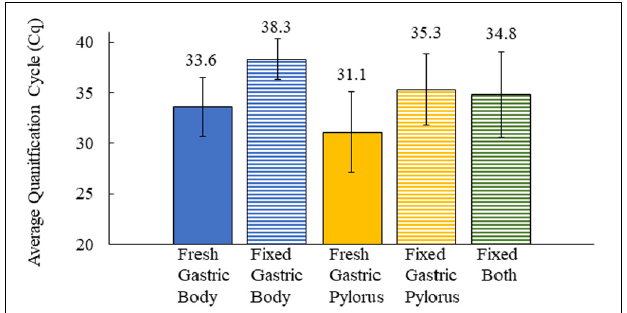
FIGURE 3 | Comparison of the average quantification cycle for sea otter gastric tissues as fresh-frozen (fresh) ( n = 92) and formalin-fixed, paraffin-embedded (fixed) ( n = 59) samples. Fixed both = gastric body and pylorus in same paraffin-embedded sample. Error bars = standard